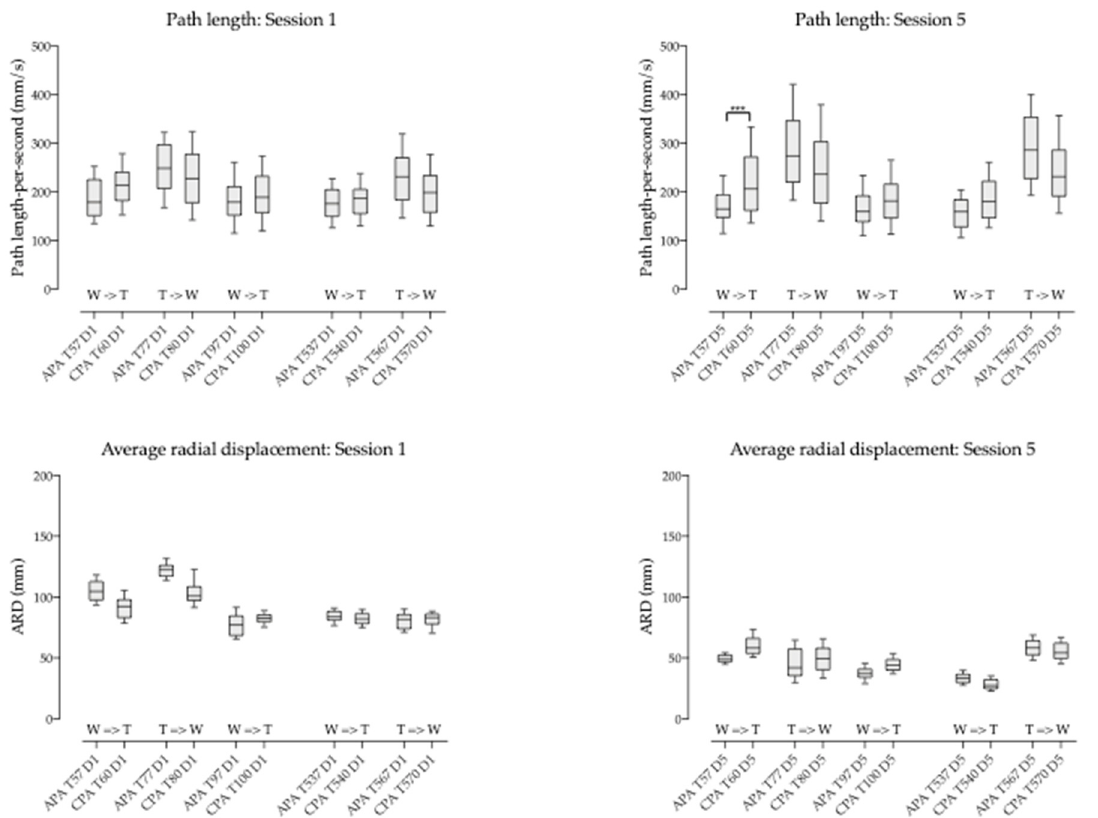
Figure 6. Comparison of consecutive compensatory versus anticipatory postural adjustments (CPA versus APA) for the two measured variables (COP path length and COP ARD) at different times during both sessions.